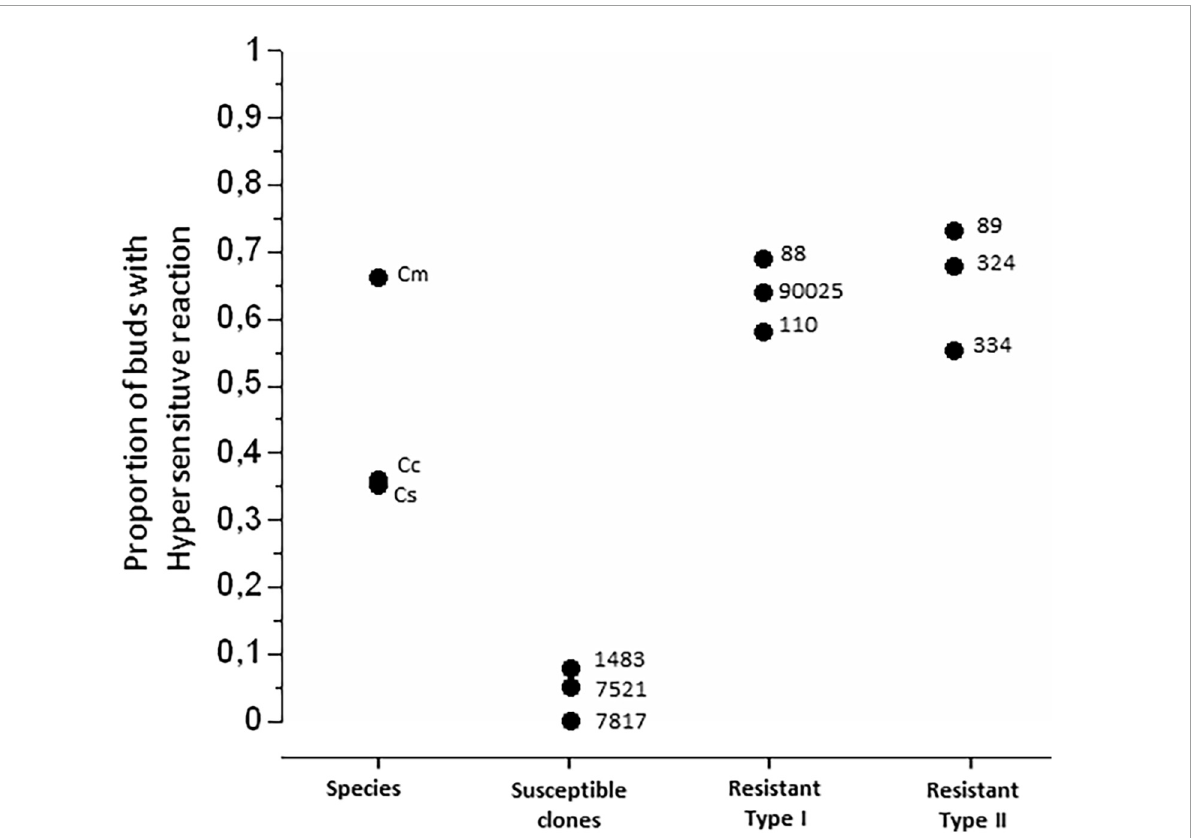
FIGURE5 Proportion of buds showing necrotic lesions consistent with hypersensitive response. Each point represents one species or hybrid, each represented by dissection of about 5 buds within each of about 5 trees. Numbers show the hybrid name; Cc, Castanea crenata ; Cm, C. mollissima; Cs, C. sativa